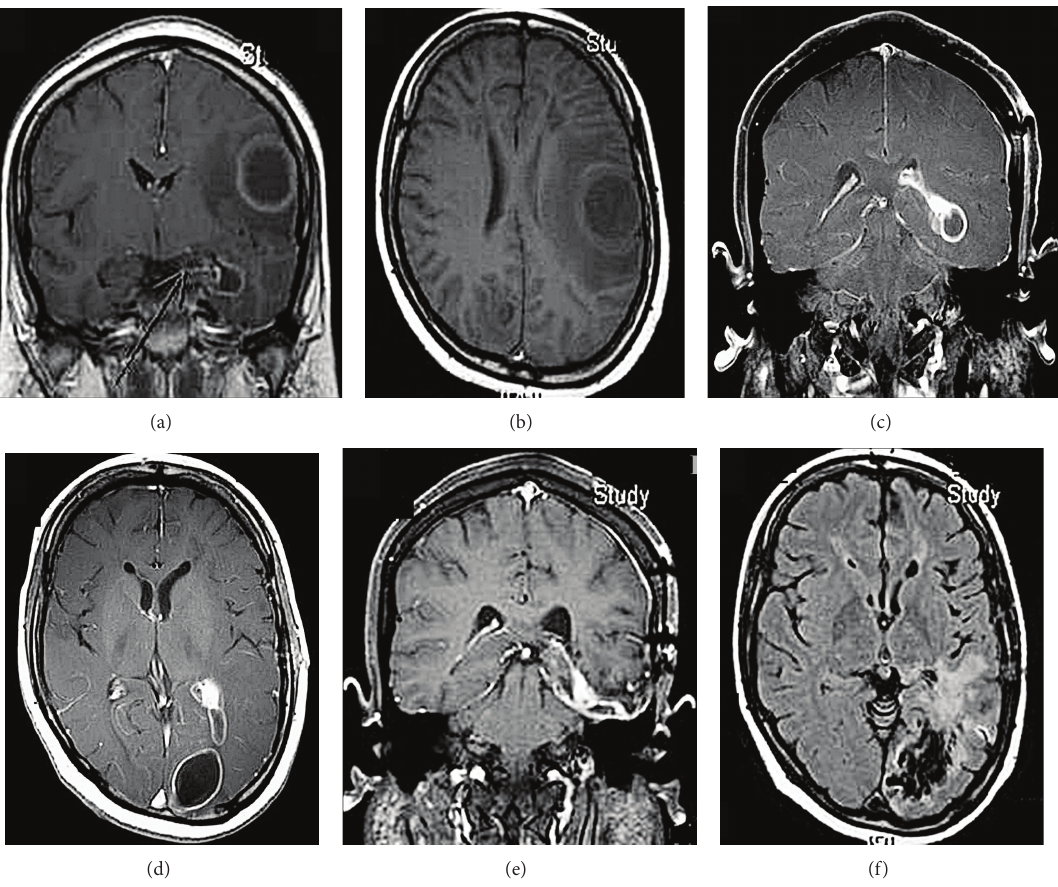
Figure 2: (a) Coronal and (b) axial brain MRI on August 5, 2006, showed the lesion over left temporal region. (c) Coronal and (d) axial brain MRI on August 24, 2006, revealed interval progression of the other abscess in the left occipital regions and the left lateral ventricle. (e) Coronal and (f) axial brain MRI on October 26, 2006, revealed interval regression of the abscesses over the left occipital regions and the left lateral ventricle. Previous residual brain abscesses and ventriculitis subsided.